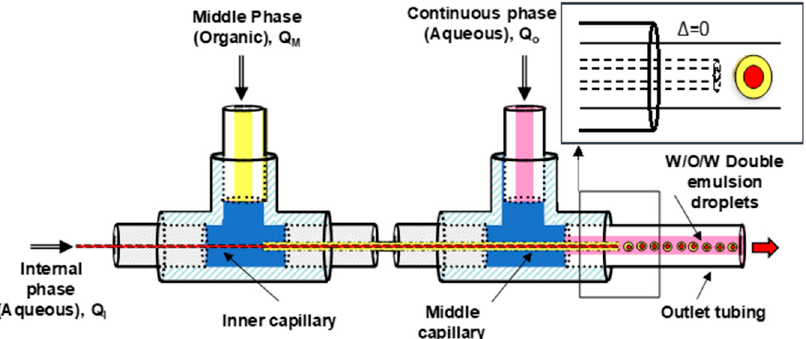
Figure 1. Scheme of the microfluidic system formed by two coaxial capillaries used for the production of Trojan MPs by double emulsion.